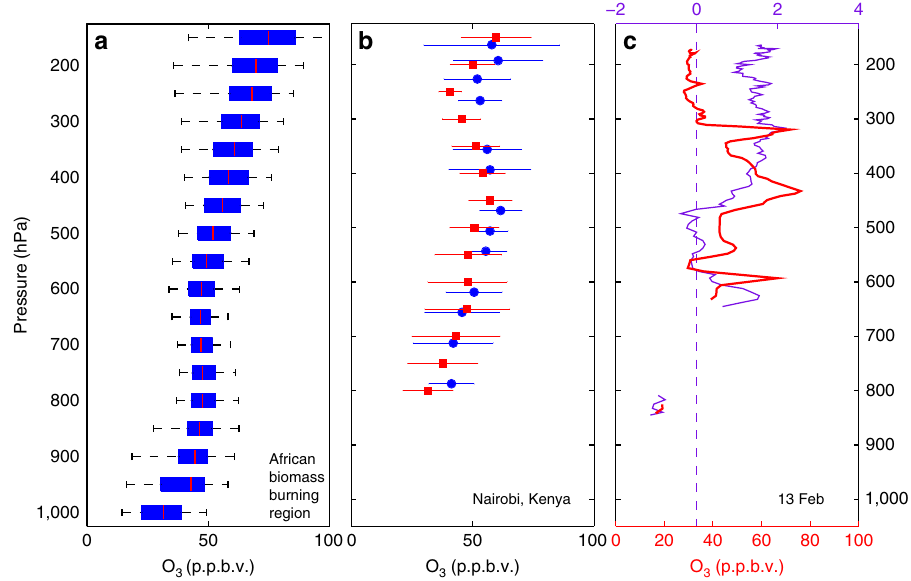
Figure 9 | Ozone over Africa and in situ potochemical ozone production in the TWP. ( a ) Vertical distribution of CAM-Chem O 3 in the African biomass burning region (that is, black box Fig. 4); 5th, 25th, median, 75th and 95th percentiles are shown. ( b ) Mean ± 1 s of SHADOZ ozonesonde observations over Nairobi, Kenya for January and February 2014 (red). Mean ± 1 s CAM-Chem O 3 modelled over Nairobi sampled on the same days as the ozonesondes (blue). ( c ) O 3 profile from Fig. 2b (red) and net O 3 production in the profile (purple, top axis), calculated using the DSMACC photochemical box model (see Methods